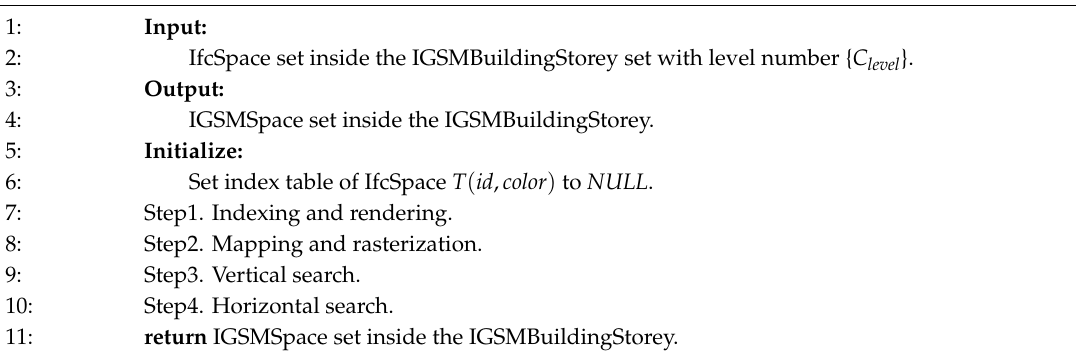
Algorithm 3. Indoor Adjacency Extraction